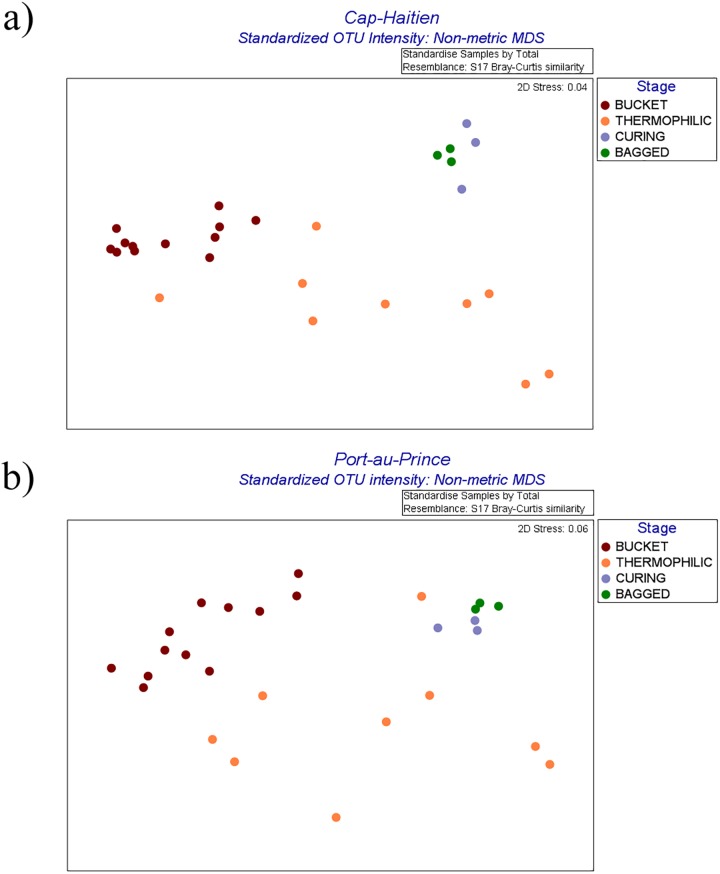
Non-metric multidimensional scaling (NMDS) plots of Bray-Curtis similarity matrices based on standardized OTU intensities.Number of samples at each stage at each location were: Bucket (12), Thermophilic compost (9), Curing (3), Bagged (3). a) Cap-Haitien, b) Port-au-Prince